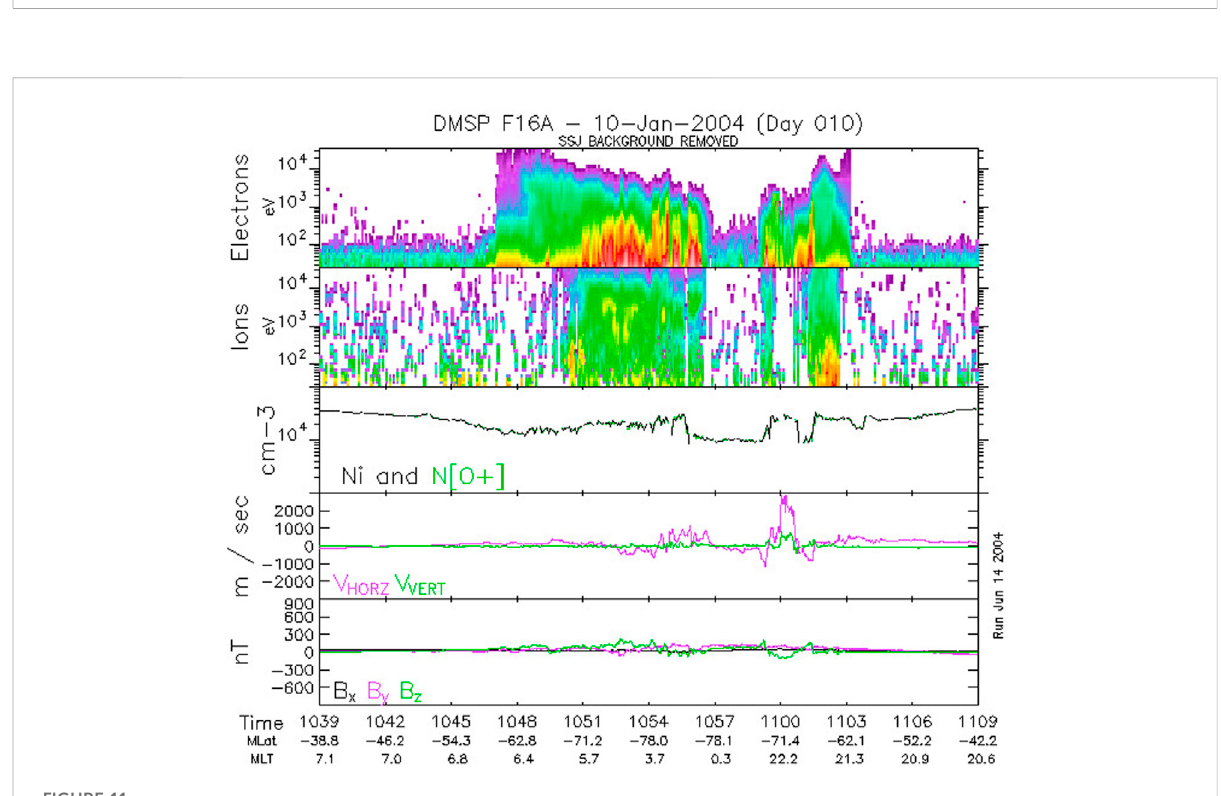
FIGURE 11 Satellite F16 fi eld and plasma data collected on a dawn-dusk pass reaching to high MLATs in the Southern hemisphere. The focus is on the sunward-directed, 3 km/s fl ow burst at around 11 UT (panel 4). For further details, see